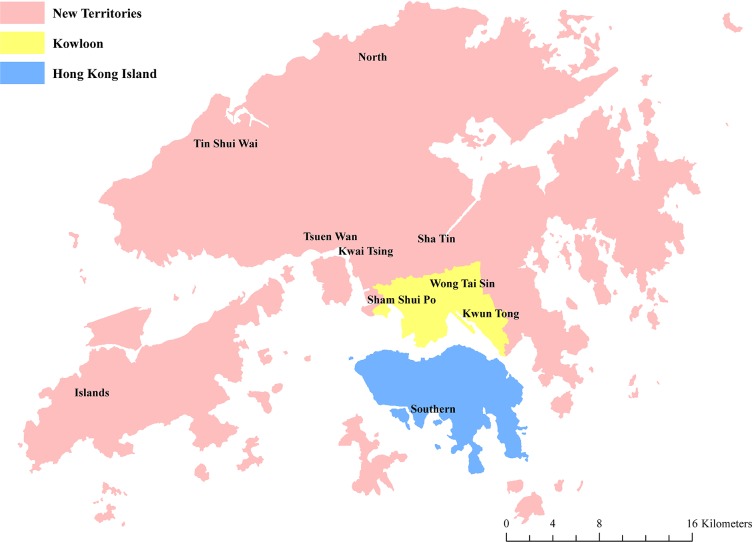
Map of Hong Kong (data in S1 File).